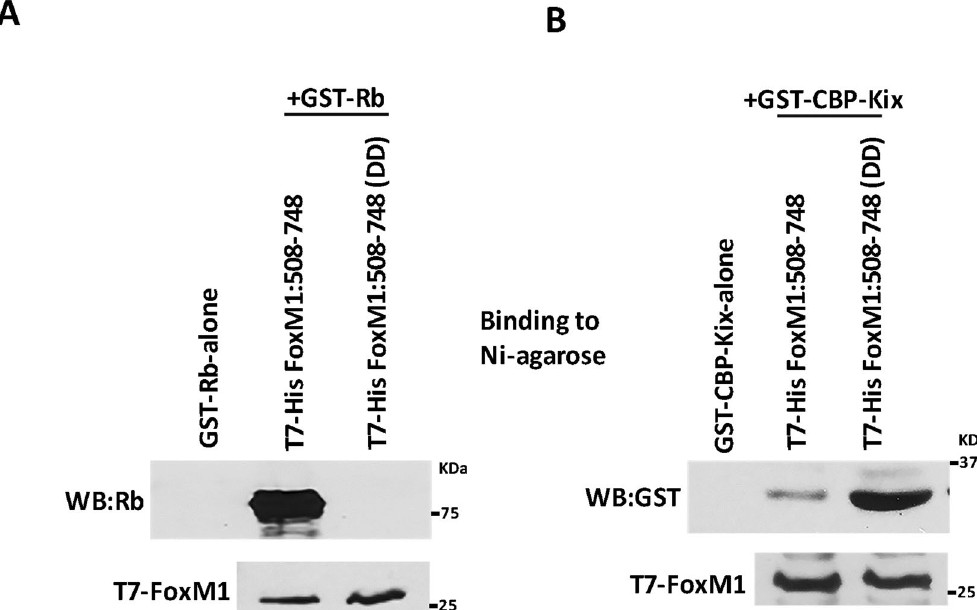
Figure 1. A Plk1-site phospho-mimetic mutant of FoxM1b fails to bind Rb in vitro . T7-His tagged C-terminal FoxM1 (residues 508–748), Plk1-site phospho-mimetic DD mutant, and GST-Rb (residues 379–928) were all expressed separately in E. coli . The bacterial lysates of the wild type or DD mutant FoxM1 were mixed with the lysates containing either GST-Rb or GST-CBP-KIX and then were allowed to bind Ni-agarose column. The eluted proteins, after extensive washing of the column, were assayed for the presence of Rb and CBP by western blotting ( A and B ). The left lane in each of the panels indicates the absence of Rb or CBP-KIX in the column elute when GST-Rb or CBP-KIX were passed through the Ni column in absence of